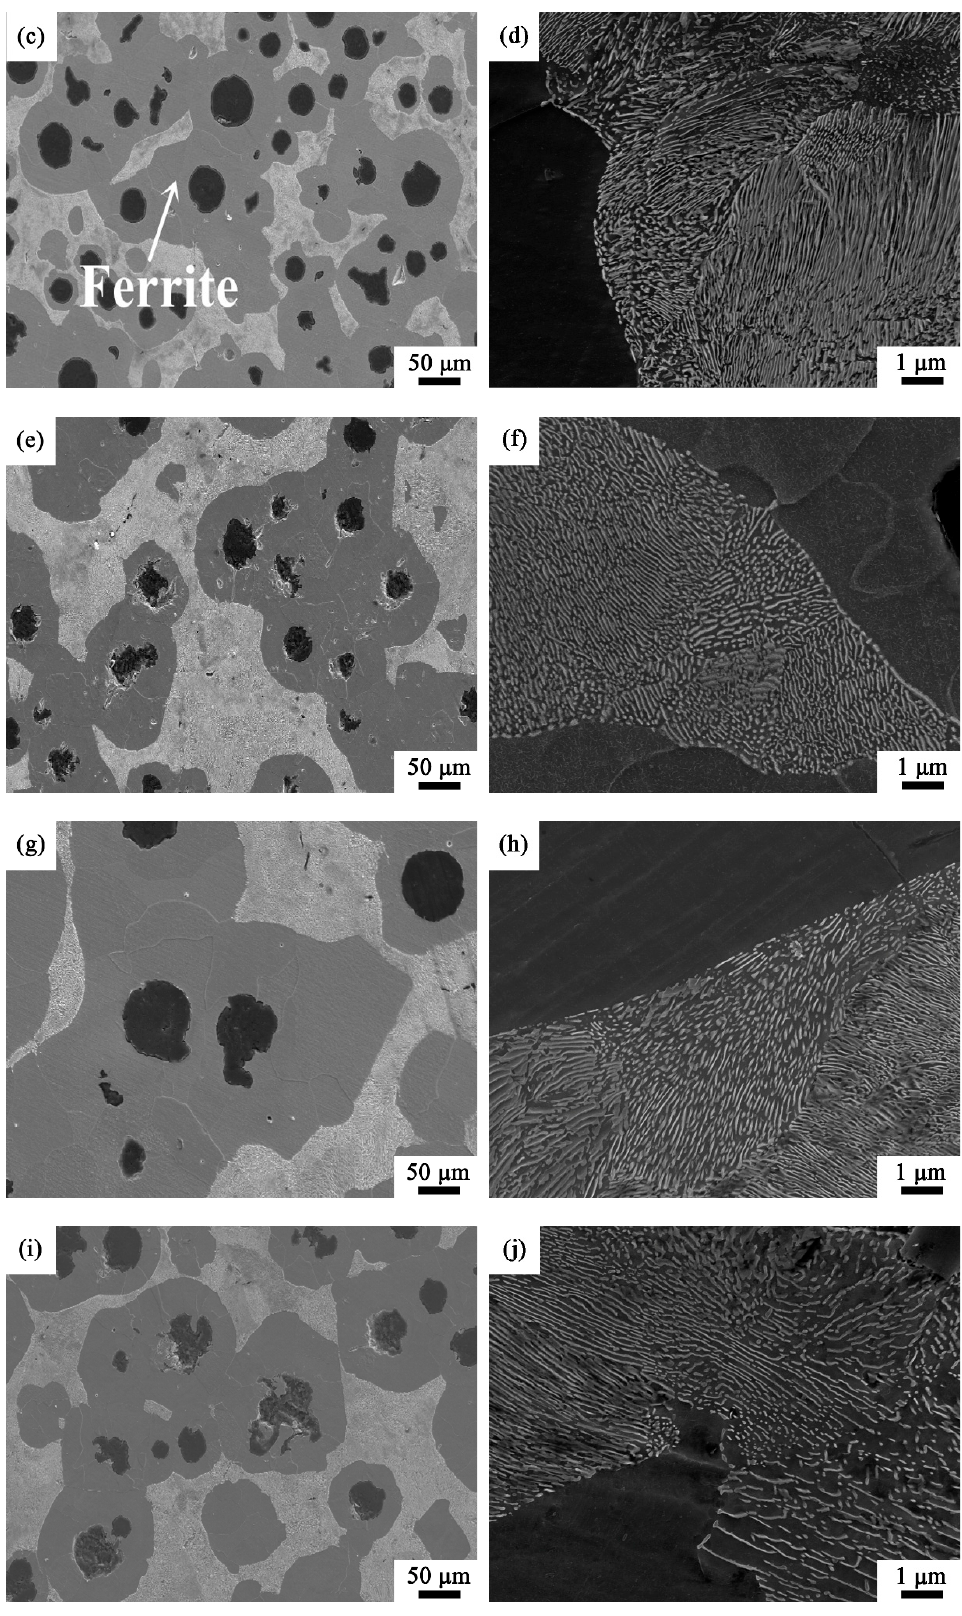
Figure 4. Microstructure of different as-cast specimens: ( a , b ) AC 60, ( c , d ) AC 75, ( e , f ) AC 95, ( g , h ) AC 120, ( i , j ) AC 150. Nodular graphite (black), ferrite (dark grey), and pearlite (light grey,